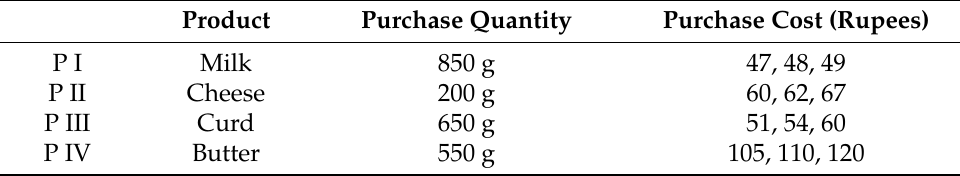
Table A1. Quantity and purchase cost of four products at suppliers.